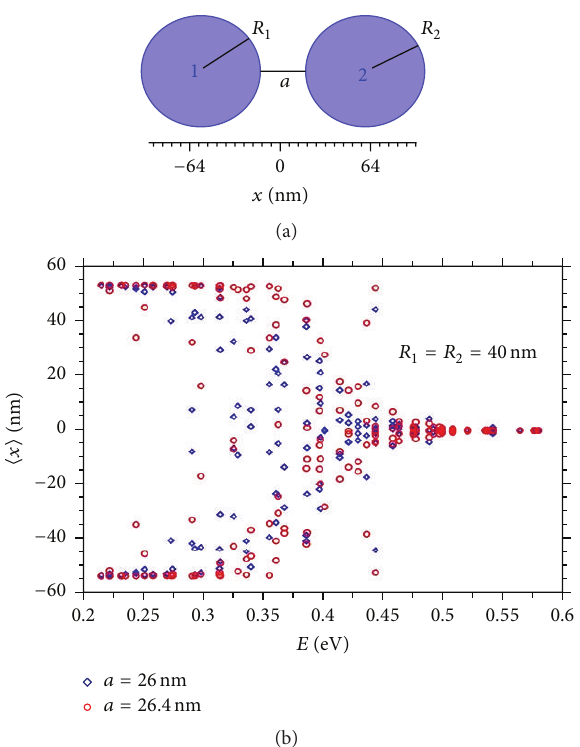
Figure 3: Effects of the interdot distance, 𝑎 , on the spectrum of a DQW made of symmetric circular InAs/GaAs dots ( 𝑅 1 = 𝑅 2 = 40 nm). (a) Schematic representation of geometry parameters of DQW. (b) The average coordinate ⟨𝑥⟩ calculated for each level of single electron DQW